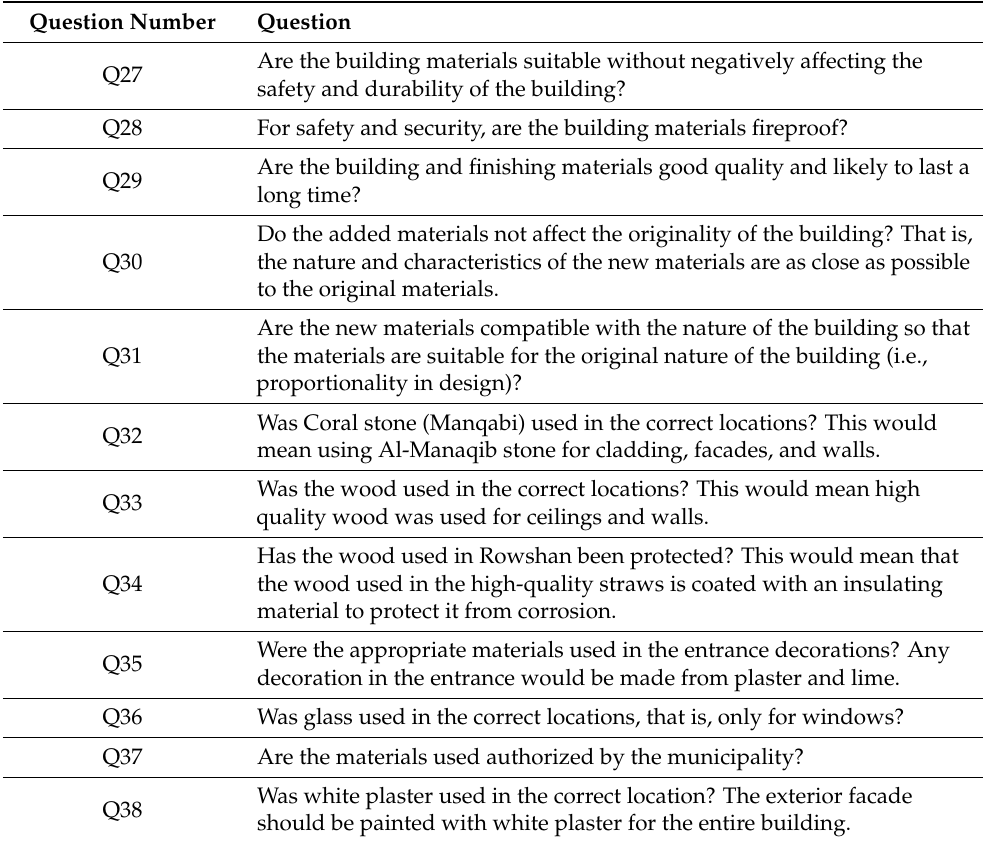
Table 6. Architectural design questions (construction and